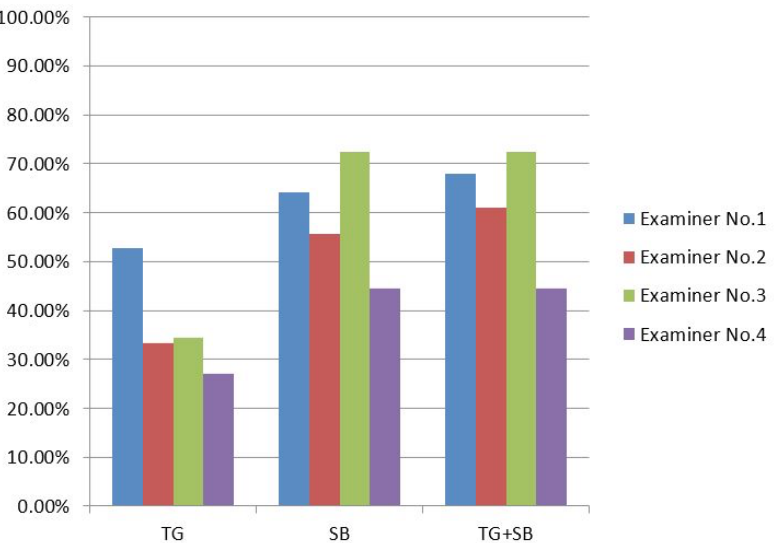
Fig. 2. Inter-individual variability of detection rates in the first biopsy group. Systematic biopsy (SB), targeted biopsy (TG).